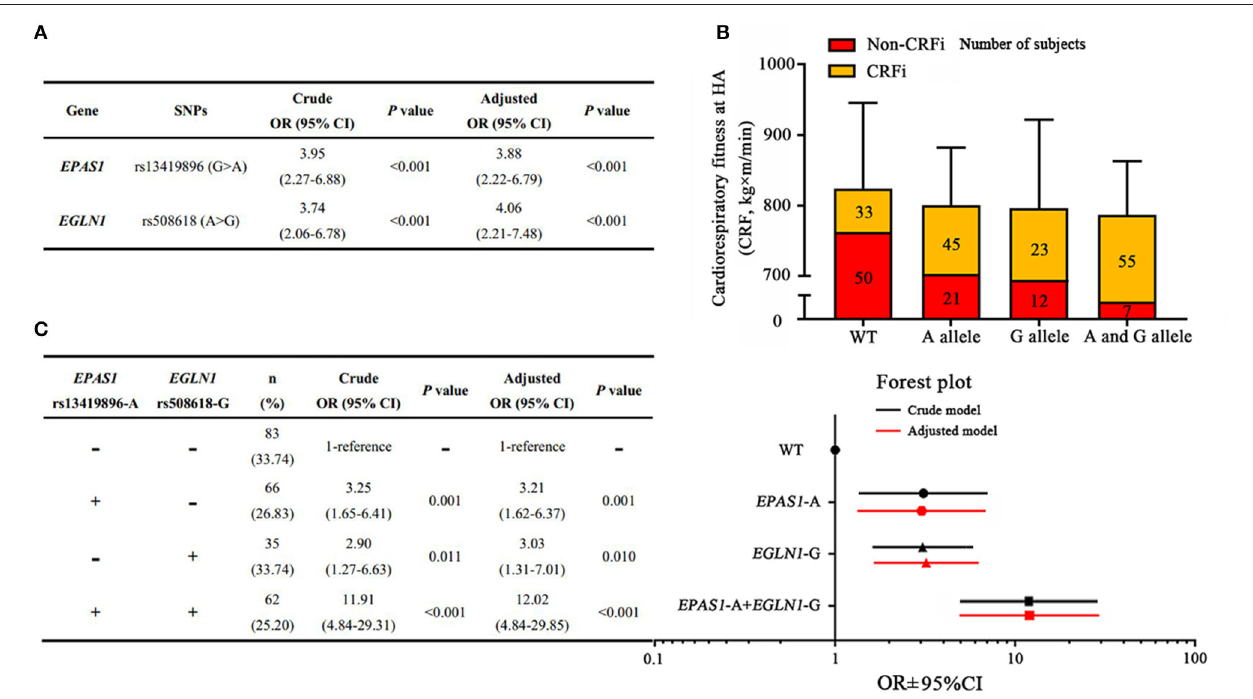
FIGURE 4 | Associations between polygenic variants and risk of high-altitude CRFi. (A) The association of EPAS1 and EGLN1 with HA cardiorespiratory fitness. (B) The distribution of subjects and cardiorespiratory fitness in each group. A total of 246 subjects were divided into four subgroups according to the genotype. Wild type (WT) represents the subjects carrying neither EPAS1 rs13419896-A nor EGLN1 rs508618-G, and the cardiorespiratory fitness in this group was 800.83 (798.83–936.41) kg × m/min. The A allele represents the subjects carrying EPAS1 rs13419896-A but not EGLN1 rs508618-G, and the cardiorespiratory fitness in this group was 798.83 (730.64–907.20) kg × m/min. The G allele represents the subjects carrying EGLN1 rs508618-G but not EPAS1 rs13419896-A, and the cardiorespiratory fitness in this group was 797.05 (735.75–800.83) kg × m/min. The A and G alleles represent the subjects carrying both EPAS1 rs13419896-A and EGLN1 rs508618-G, and the cardiorespiratory fitness in this group was 782.46 (683.16–810.00) kg × m/min. There was no significant difference between the groups at HA. The yellow and red squares represent the proportion of CRFi and non-CRFi in each subgroup. The number of subjects in each subgroup is shown on the histogram. (C) The association of the four subgroups with HA cardiorespiratory fitness. The forest plot shows the OR and 95% CI of subgroups compared to the WT in the adjusted model. The x-axis of the forest plot was numbered using log10 in GraphPad prism 7.0. WT, wild type; SNP, single nucleotide polymorphism; CRFi, cardiorespiratory fitness impairment; OR, odds ratio; 95% CI, 95% CI; HA, high altitude. Adjusted for age, BMI, ethnicity, as well as current smoking and drinking